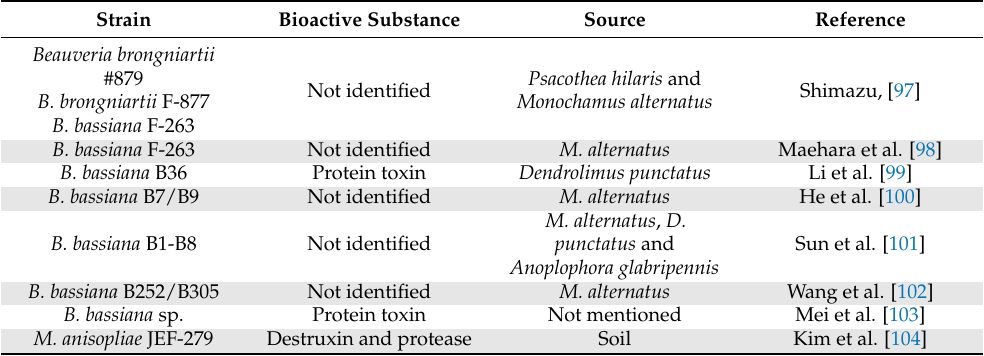
Table 2. Biocontrol microorganisms in the control of Monochamus alternatus